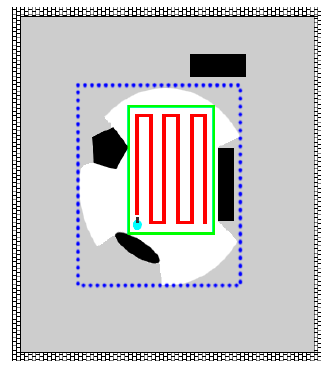
Figure 7. The coverage path planning for Rmap with the Boustrophedon algorithm. The blue box is MBR, the green box is R1, and the red line is the created path using the Boustrophedon.